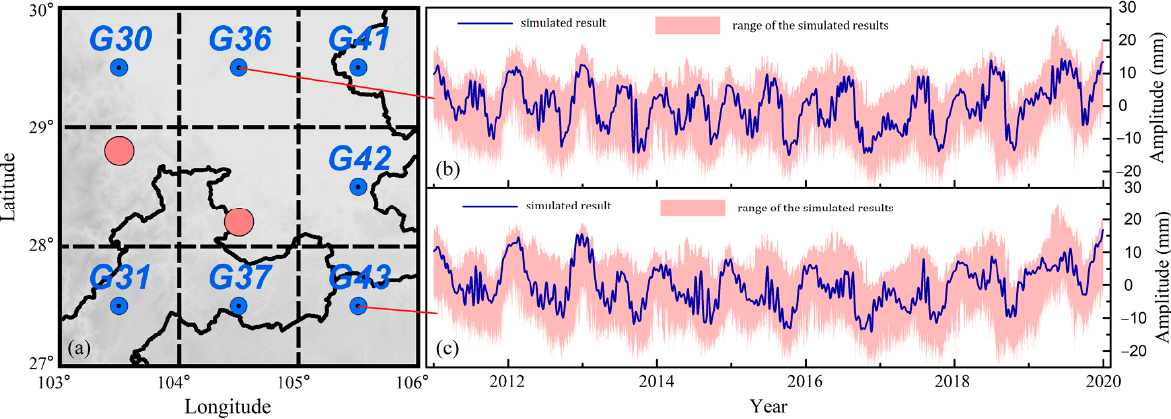
Figure 6. The regressed result of crustal deformation in the unobserved grids, taking G36 and G43 as an example. It can be seen from Figure 6 that the annual and the semi-annual items can be effec- tively simulated in the unobserved grids. Then the models of MERRA and OMCT are used to correct the loading of atmospheric [33] and non-tidal ocean [63], respectively. First, we calculate the Green’s function over southwest China with the spatial resolution and radius of 0.25 ◦ and 13.90 km [24]. Meanwhile, the values of the expanding border and β equal 2 ◦ and 0.01. The TWSA in southwest China from 2011 to 2019 can be derived based Remote Sens. 2021 , 13 , x FOR PEER REVIEW on Formula (5) and the result of the TWSA is shown in Figure 7.